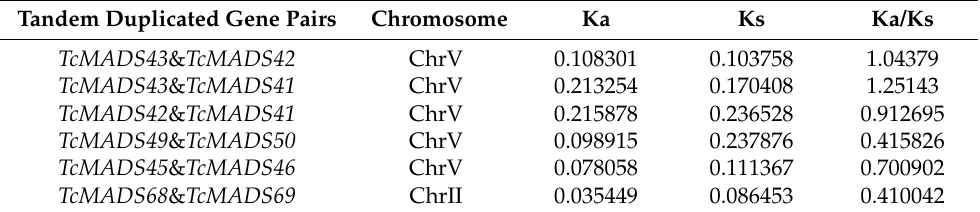
Table 2. Tandem duplicated gene pairs and their Ka, Ks, Ka/Ks values. Tandem Duplicated Gene